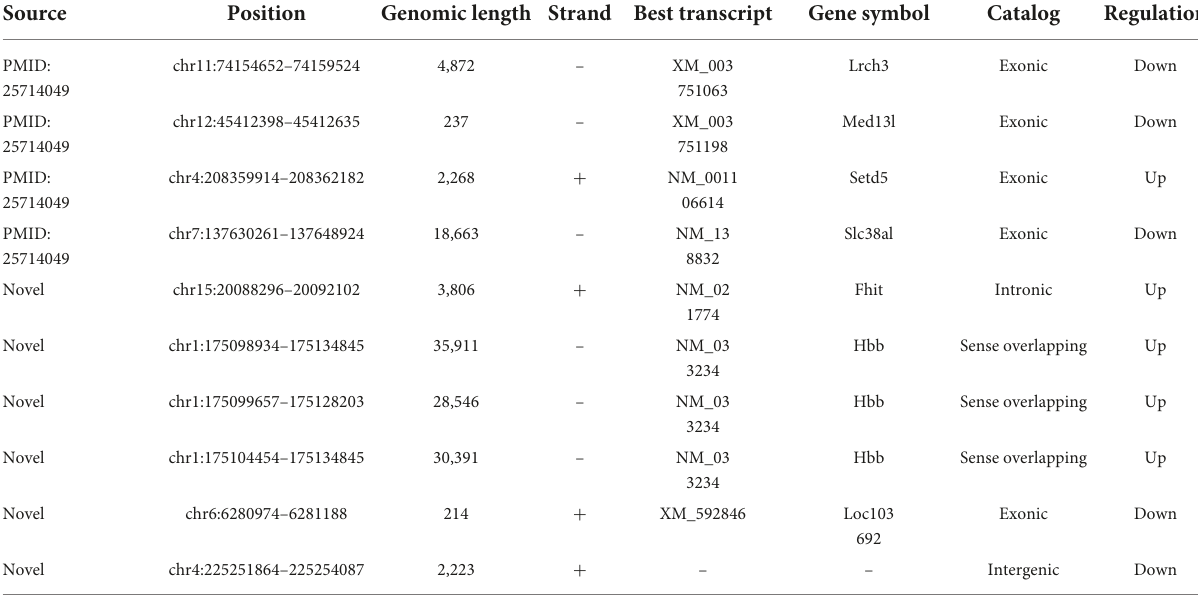
TABLE 2 Basic information of differentially expressed circular RNAs (circRNAs). Source Position Genomic length Strand Best